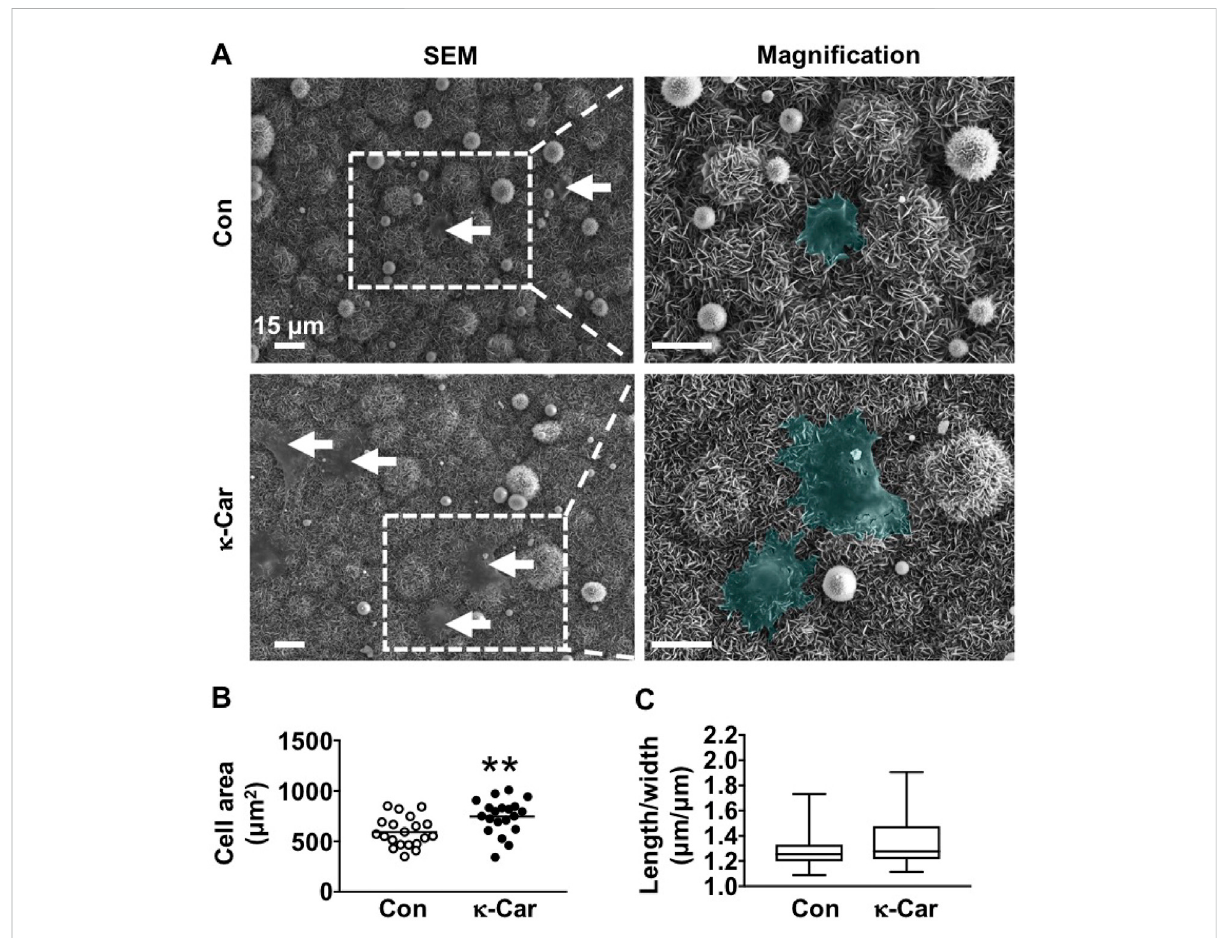
FIGURE 4 Effect of 2 mg/ml κ -carrageenan in OCP-coating of titanium discs on the spreading of MC3T3-E1 pre-osteoblasts at 1 h (A) SEM images of MC3T3-E1 pre-osteoblasts on OCP-coating. Arrows: cells (green). (B) Quanti fi cation of cell surface area. (C) Cell length/width ratio. Values are mean ± SD. n = 9 from 3 independent experiments. Signi fi cant effect of κ -carrageenan, ** p < 0.01. Con, control; κ -Car, κ -carrageenan; SEM, scanning electron microscopy. Bar: 15 μ m. Magni fi cation: